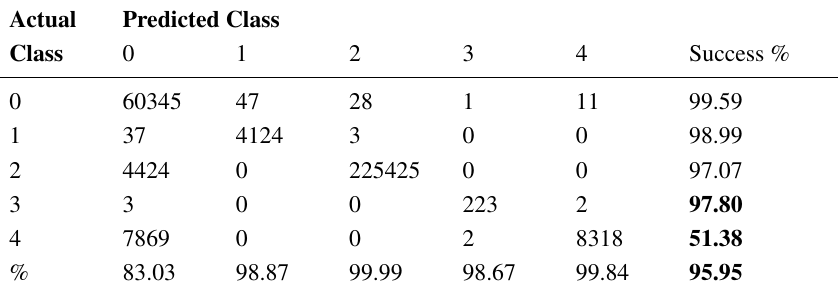
Table 4. Confusion matrix after incremental learning (Termination Condition